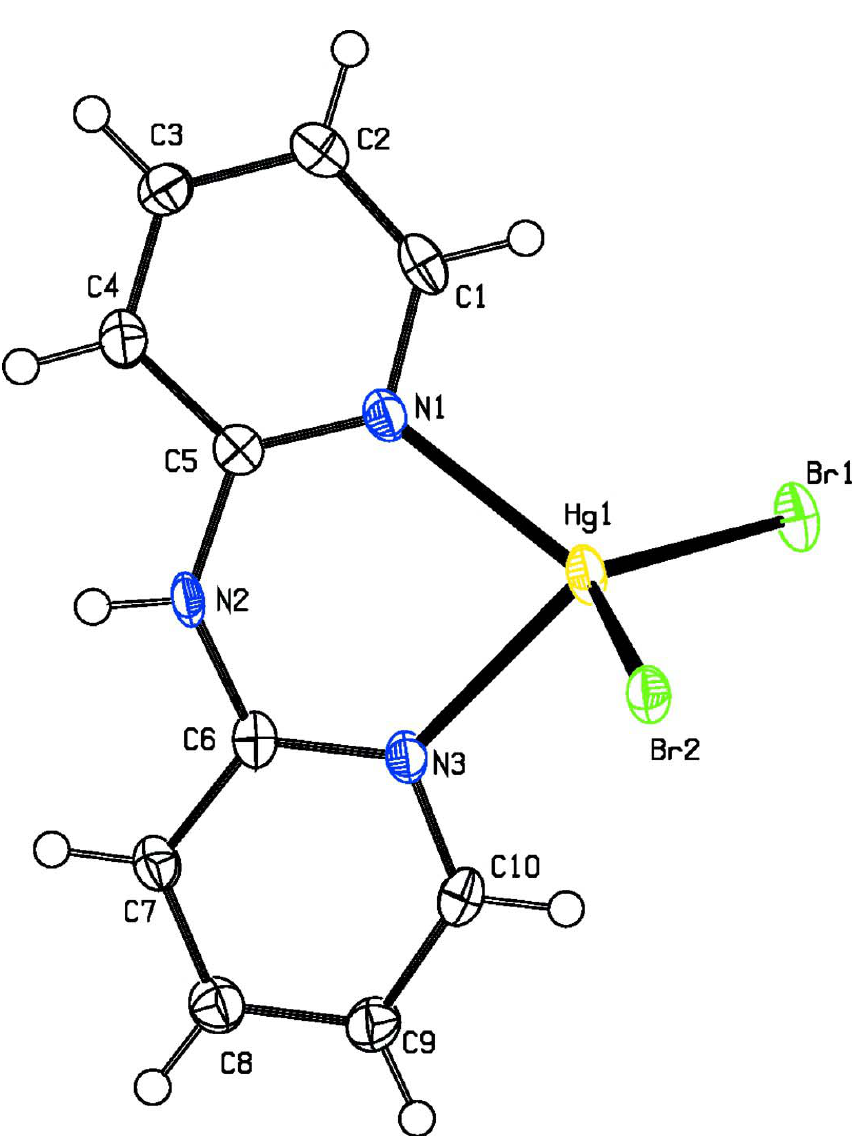
Figure 1 The molecular structure of the title molecule, with the atom-numbering scheme. Displacement ellipsoids are drawn at the 50% probability